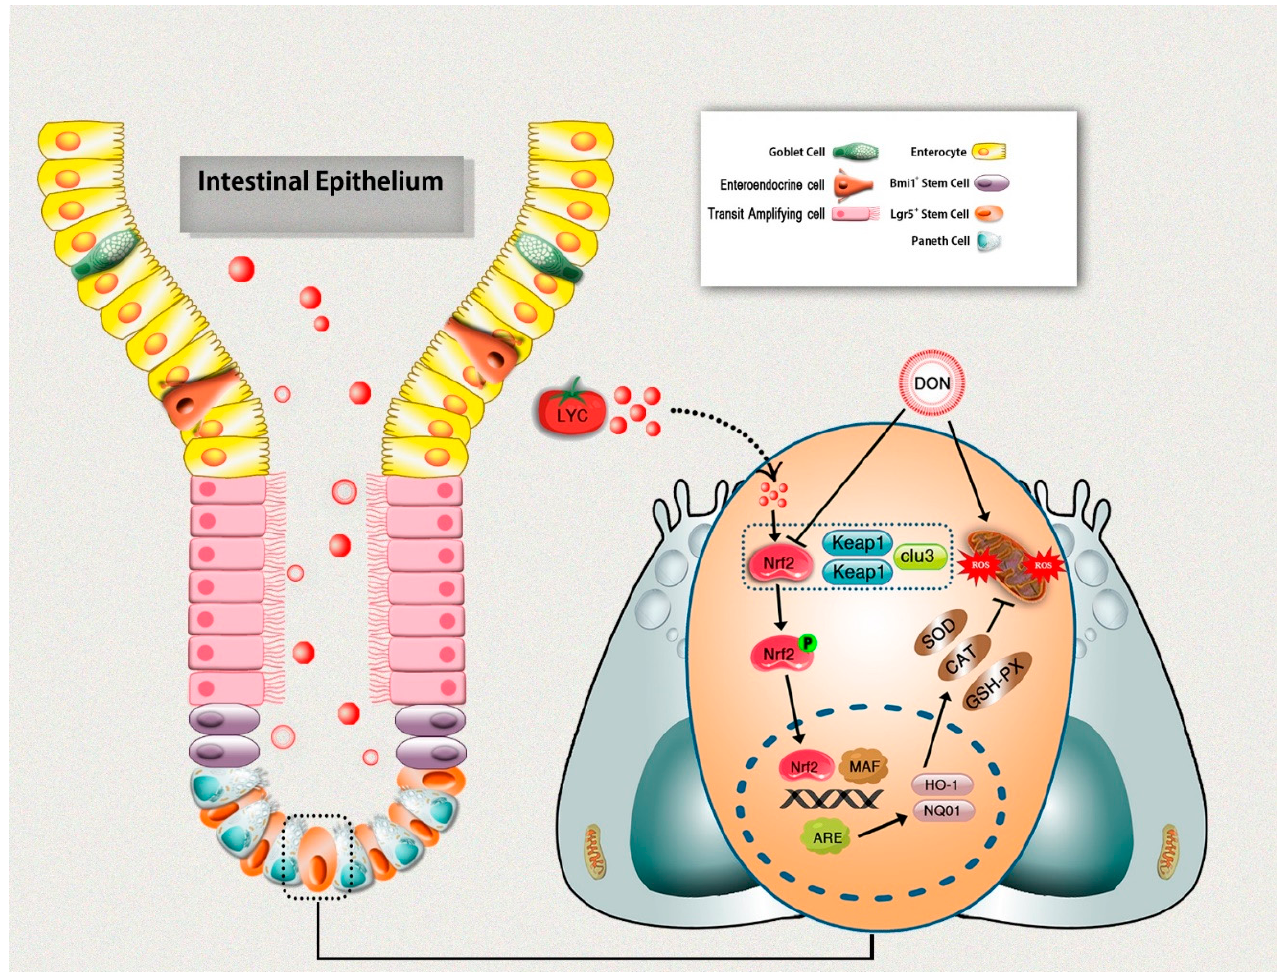
Figure 7. Schematic diagram representing lycopene-induced protection of intestinal epithelium integrity through regulation of Keap1/Nrf2 signaling pathway under DON exposure.